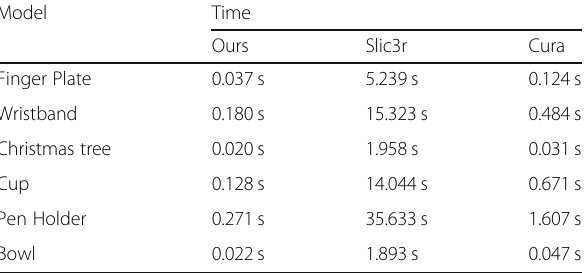
Table 2 Time cost of different algorithm Model